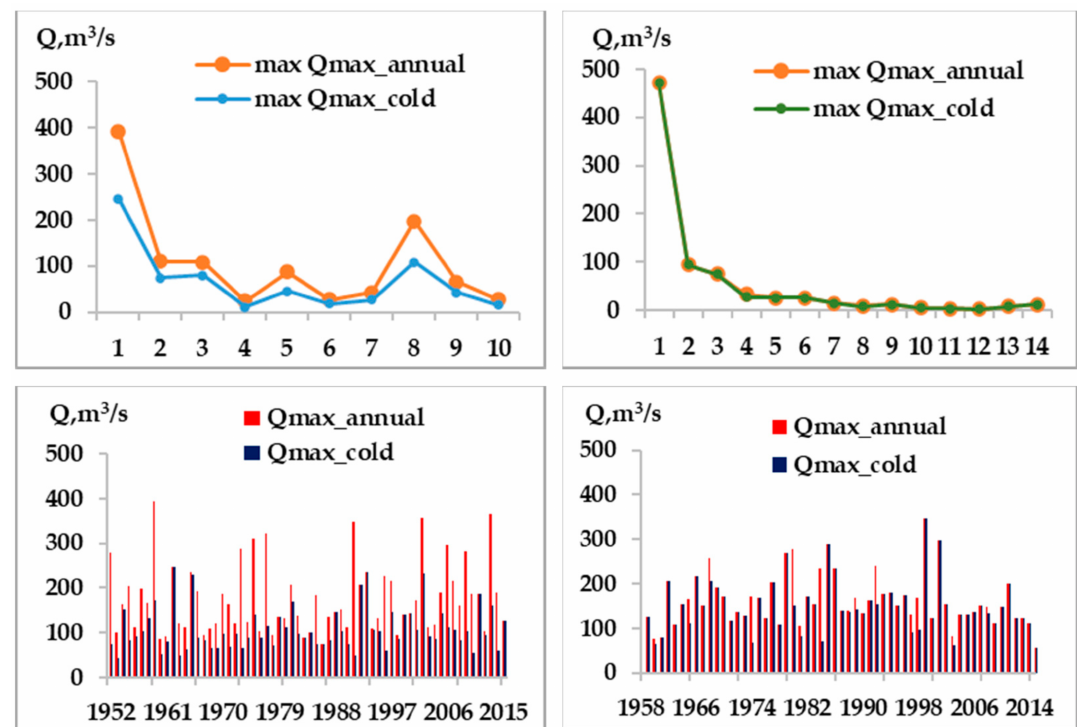
Figure 2. Comparison of the long-term maximum winter and annual floods in the upper Steyr ( top left ) and the upper Rika ( top right ) catchments. Labels of symbols refer to ID number in Table 1 (upper Rika) and Table 2 (upper Steyr), bottom left —Steyr River—Klaus an der Pyhrnbahn, bottom right —Rika River—Mizhhiria.